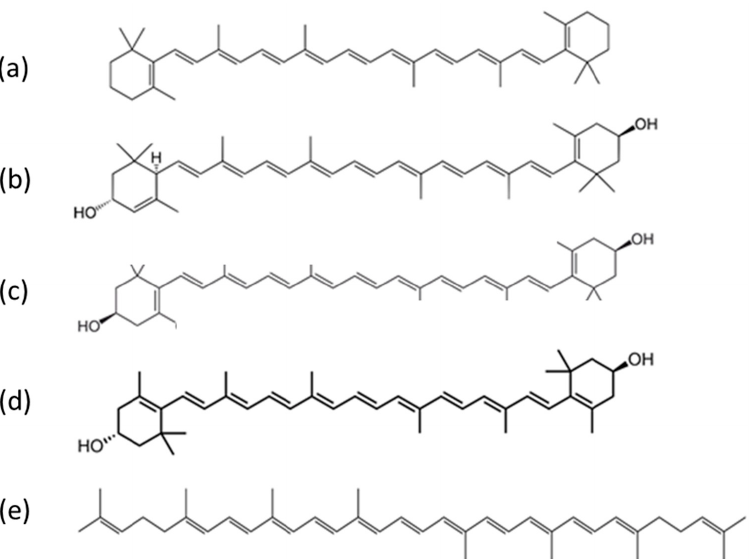
Figure 1. Examples of carotenoid compounds of relevance to human health: ( a ) beta carotene, ( b ) lutein, ( c ) zeaxanthin, ( d ) meso-zeaxanthin and ( e ) lycopene (public domain images reproduced from Wikimedia Commons). Table 1. Mean carotenoid concentration in human blood plasma [17].